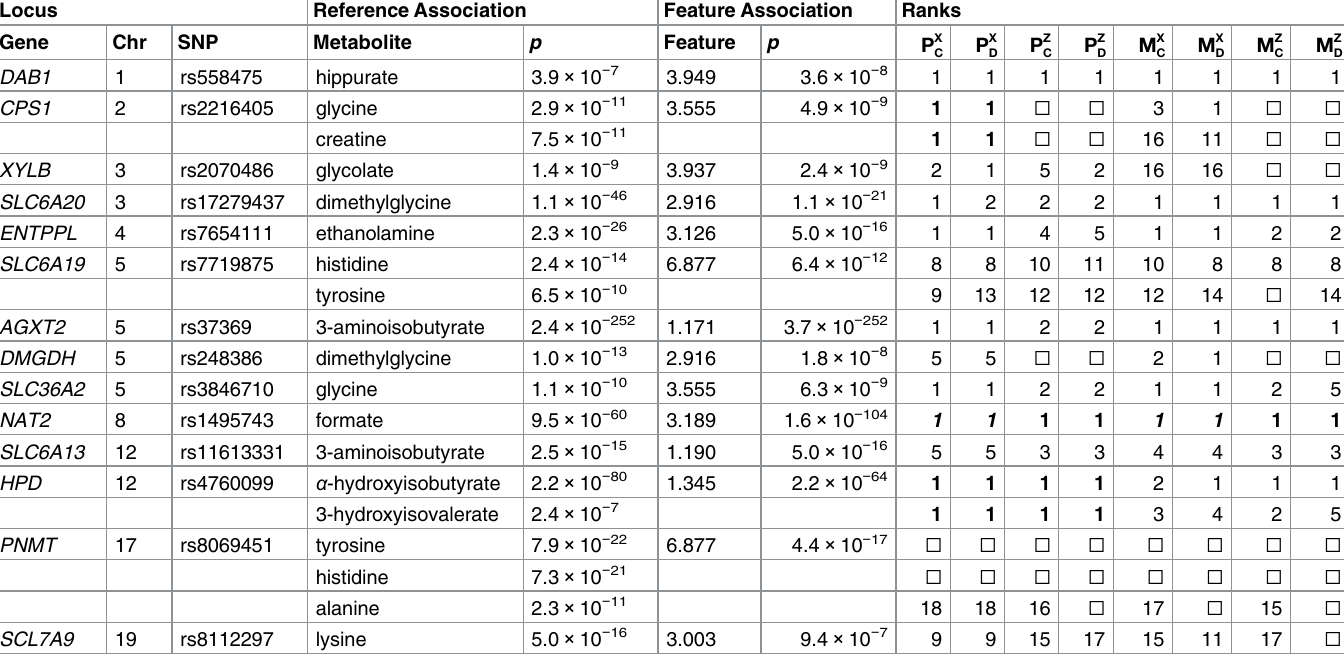
Table 2. SHIP metabomatching results. Metabomatching ranks of reference metabolites obtainedfor SHIP pseudospectra, with UMDB as the spectral ref- erence database, and with: peak- (P) or multiplet-mode (M), χ 2 - (X) or Z -scoring(Z), and without (C) or with decorrelation (D). Neighborhood parameter is δ = 0.03 in peak-mode and 0.01 in multiplet-mode. Shrinkageparameter is λ = 0.5 for decorrelation, 1 without. Ranks obtainedwith 2-compoundmetabomatching are shown in bold, those obtainedwith ± -2-compound metabomatching in bold and italic. Squares( □ ) indicate ranks not in the top 10% of UMDB listed metab- olites, that is ranks greater than 18. Individual metabomatching figures includingthe eight highest rankedmetabolitecandidates for each pseudospectrum can be found in S2 Fig.